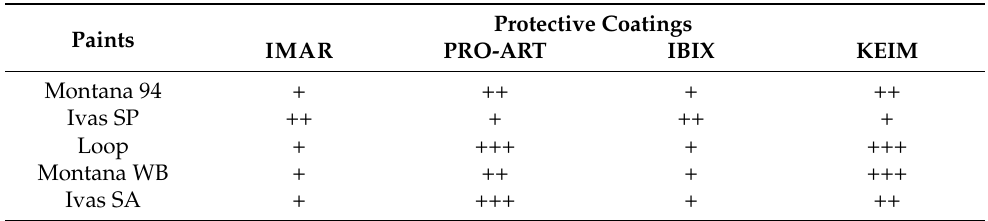
Table 4. Applicability of protective coatings over chromatic layers. Scale from + (bad) to +++ (very